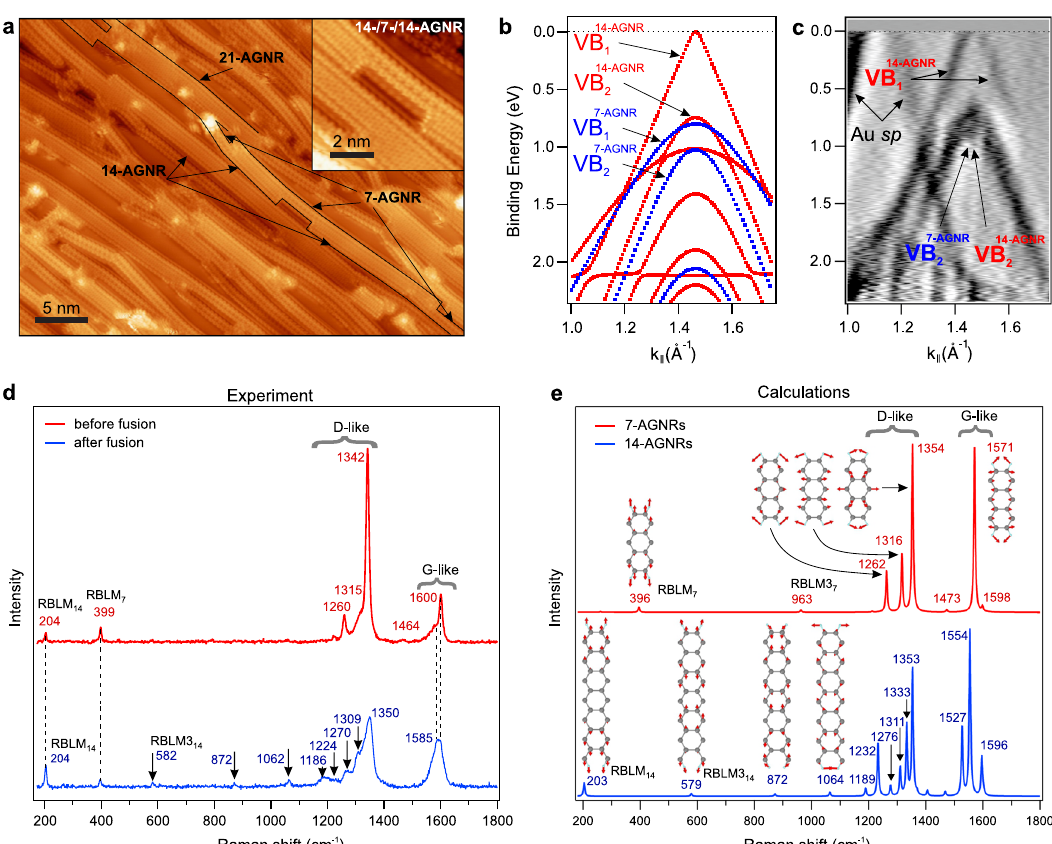
Fig. 2 Experimental characterization of the aligned GNR heterojunctions on Au(788). a STM topographic image of fused 7-AGNRs (sample bias V s = − 1.3 V, tunneling current I = 1.8 nA). The black lines outline one possible conducting path through the GNR heterojunctions: quasi-metallic 14- and 21- t AGNRs connected by 7-AGNR segments. The inset shows an example of a typical 14-/7-/14-AGNR heterojunction with a short (~3 nm) 7-AGNR